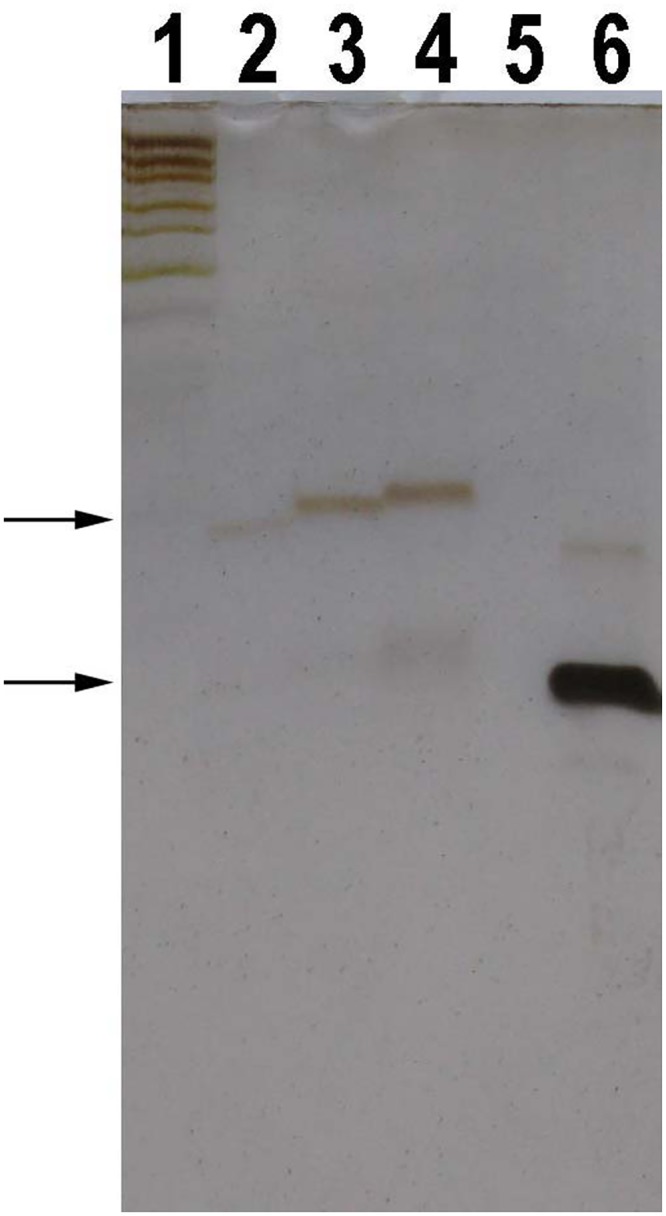
Oligos A10T10, A11T11, A12T12 and (TA)12 were silver-stained in 15% denaturing gel.DNA markers were DNA marker 1 and oligo A9. The arrows indicate the specific oligo bands. Lanes 1–6: DNA marker 1, oligos A10T10, A11T11, A12T12, (TA)12 and A9. Note: We are sorry that some DNA bands of DNA marker 1 are not clear because they are hard to be silver-stained.